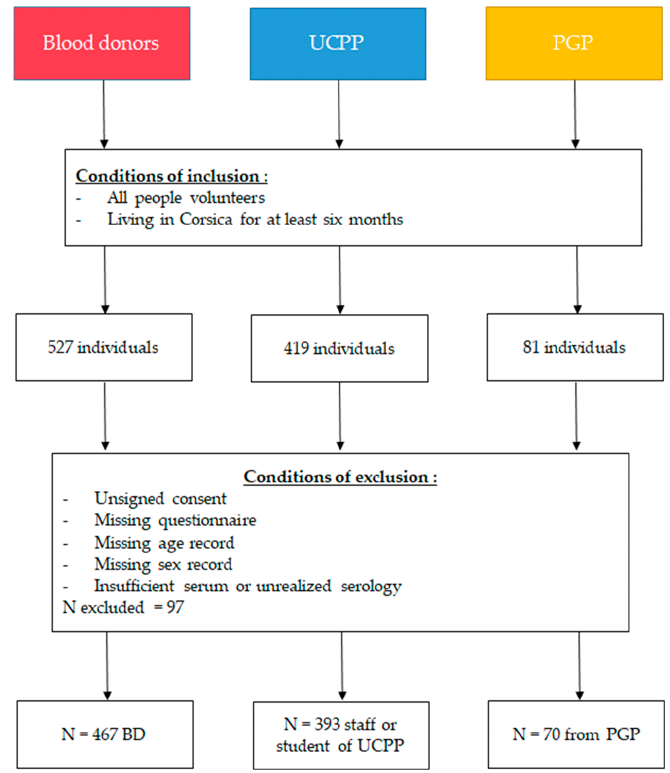
Figure 1. Flowchart for the inclusion and exclusion of studied populations .